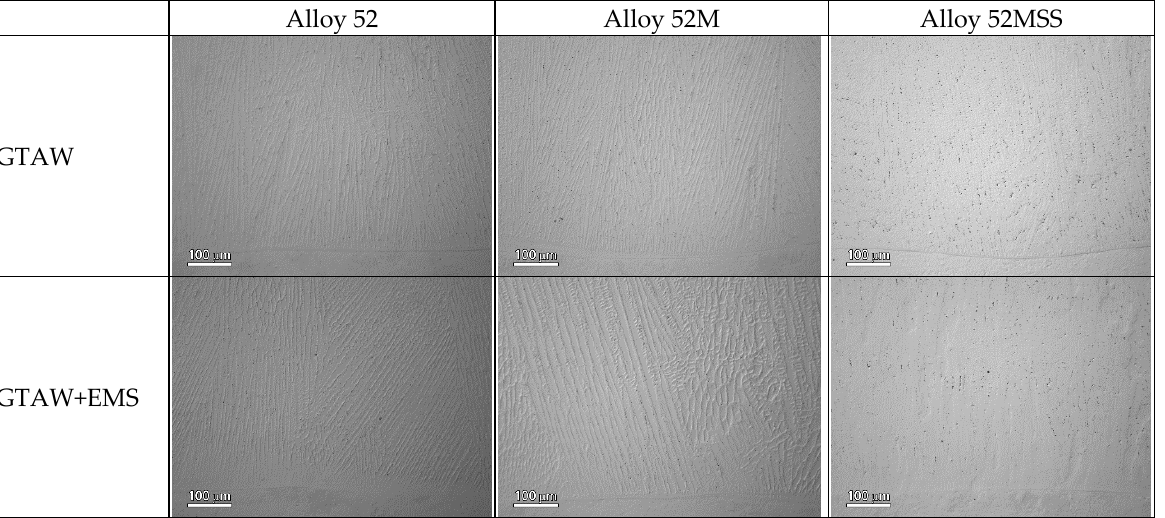
Figure 7. Micrographs of welds in the root.